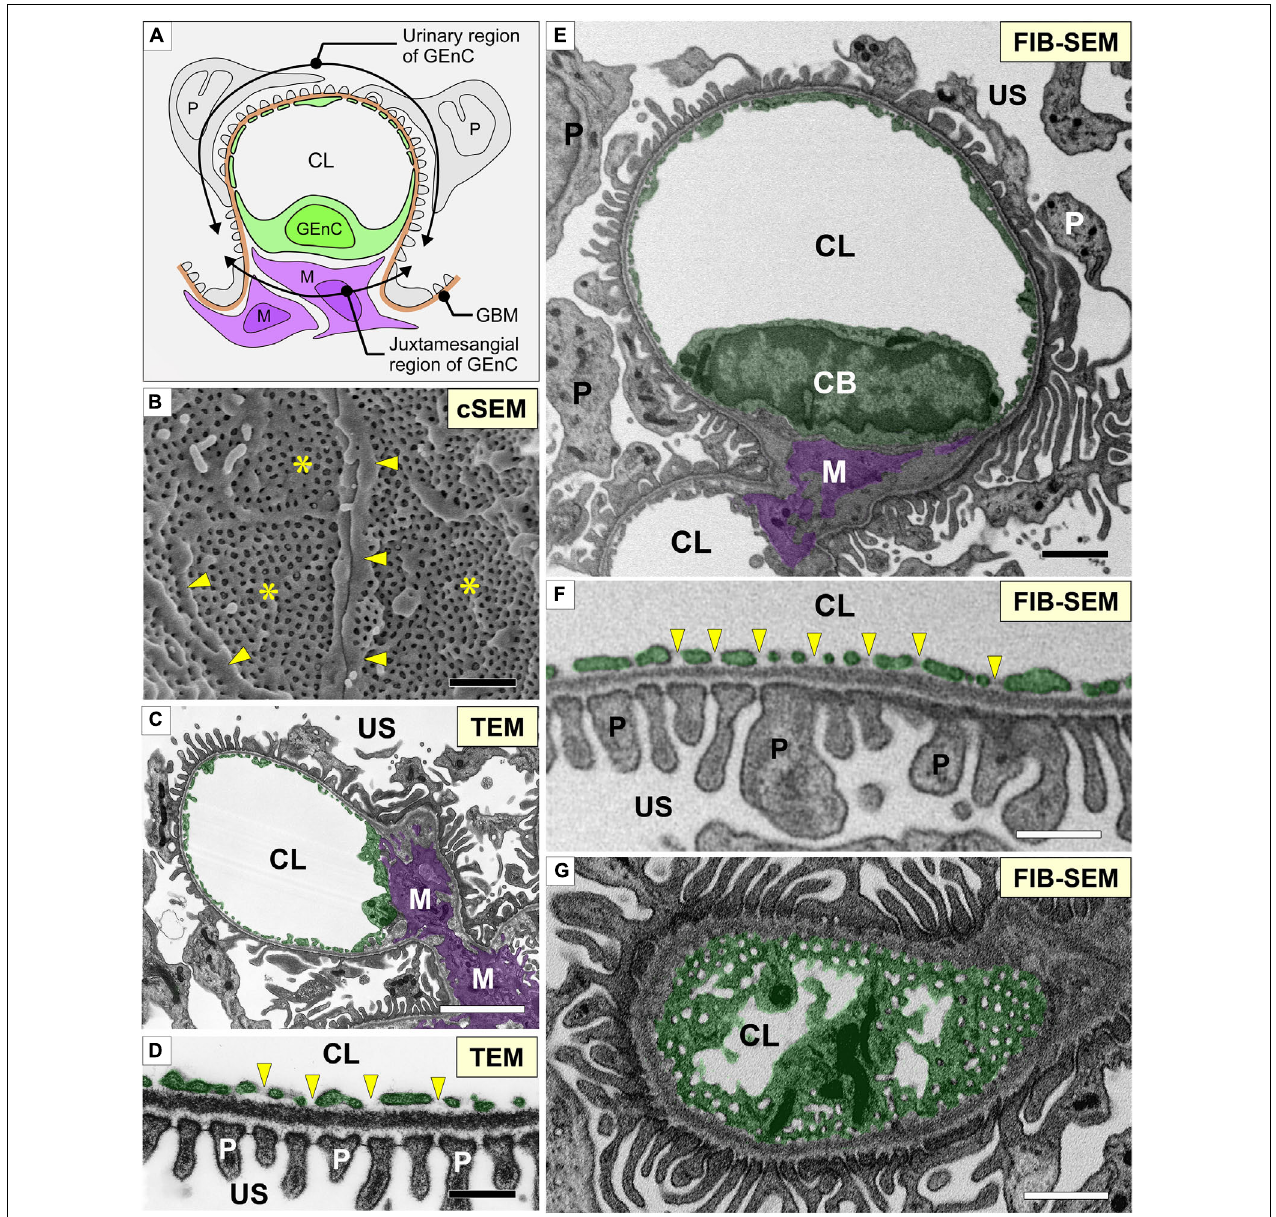
FIGURE 1 | Glomerular capillary images of conventional electron microscopy and focused-ion beam-scanning electron microscopy (FIB-SEM). (A) Two regions of a glomerular endothelial cell (GEnC) in relation to the surrounding structures, such as the glomerular basement membrane (brown line, GBM), mesangial cells (purple cells, M), and podocytes (gray cells, P). (B) Conventional SEM (cSEM) image of the luminal surface of GEnCs. Highly fenestrated sieve plates (asterisks) and cytoplasmic ridges (arrowheads) are clearly visible. (C,D) Conventional TEM images. (E–G) Contrast-inverted FIB-SEM images. Conventional TEM and FIB-SEM images showing that the transverse sections of the glomerular capillary are similar in quality (C–F) . (D,F) Magnification of glomerular capillary wall, which consists of GEnCs, the GBM, and podocyte foot processes. The fenestrae of GEnCs do not exhibit diaphragms (arrowheads in D,F ). (G) Grazing section of a capillary wall showing the fenestrae without diaphragms. CB, cell body of glomerular endothelial cell; CL, capillary lumen; US, urinary space. Scale bar, 5 µ m in (C,E,G) ; 200 nm in (B,D,F)